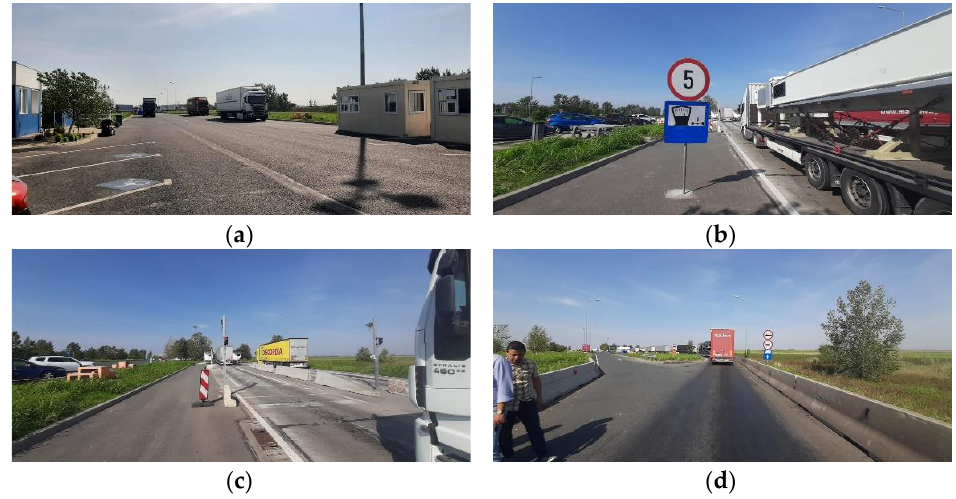
Figure 5. The important area from the BCP. ( a ) The unused lane proposed as a new path; ( b ) The scaling area; ( c ) The actual equipment for traffic control; ( d ) The proposed flows separation area.